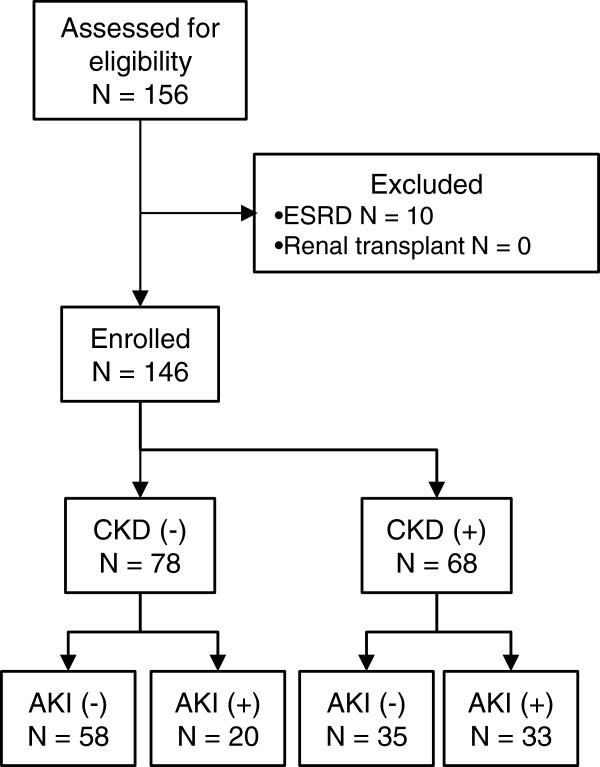
Study flow diagram. Acute kidney injury (AKI) and chronic kidney disease (CKD) were defined using the AKIN and KDIGO CKD guideline criteria.